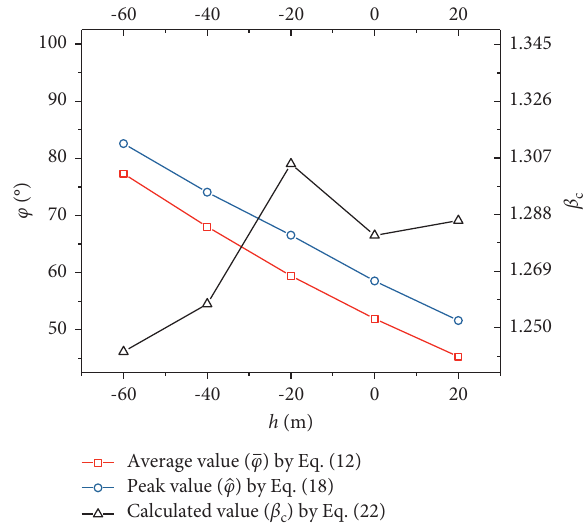
Figure 7: Influence of height difference ( h ) on the windage yaw angle ( φ